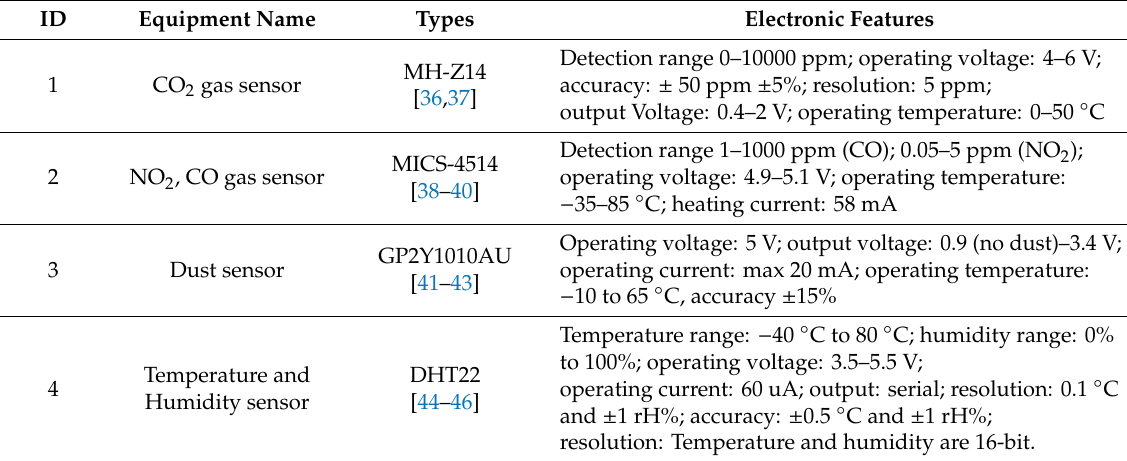
Table 1. Electronic features of the sensors in the IoT-based e-nose measuring system.